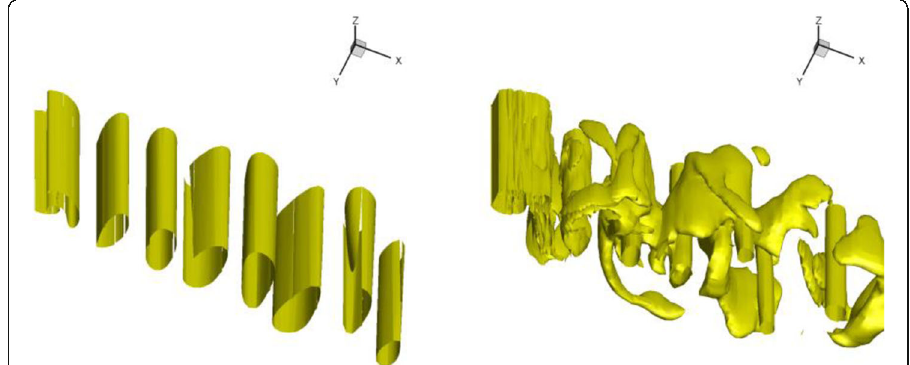
Fig. 8 Iso-surfaces of vorticity based on 2D URANS solution (left) and 3D solution obtained by modified IDDES model